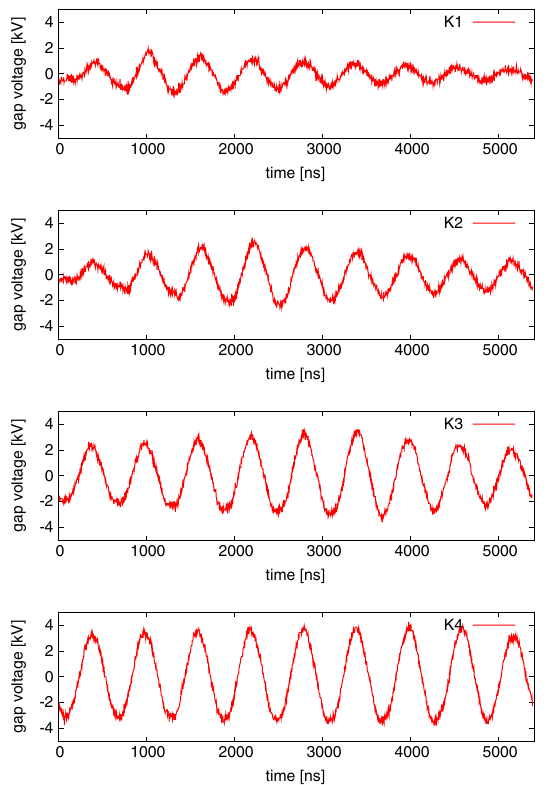
FIG. 3. Typical waveform of the wake voltage just after K1– K4 timings. (Top) K1, (second top) K2, (third top) K3, and (bottom) K4 timing.